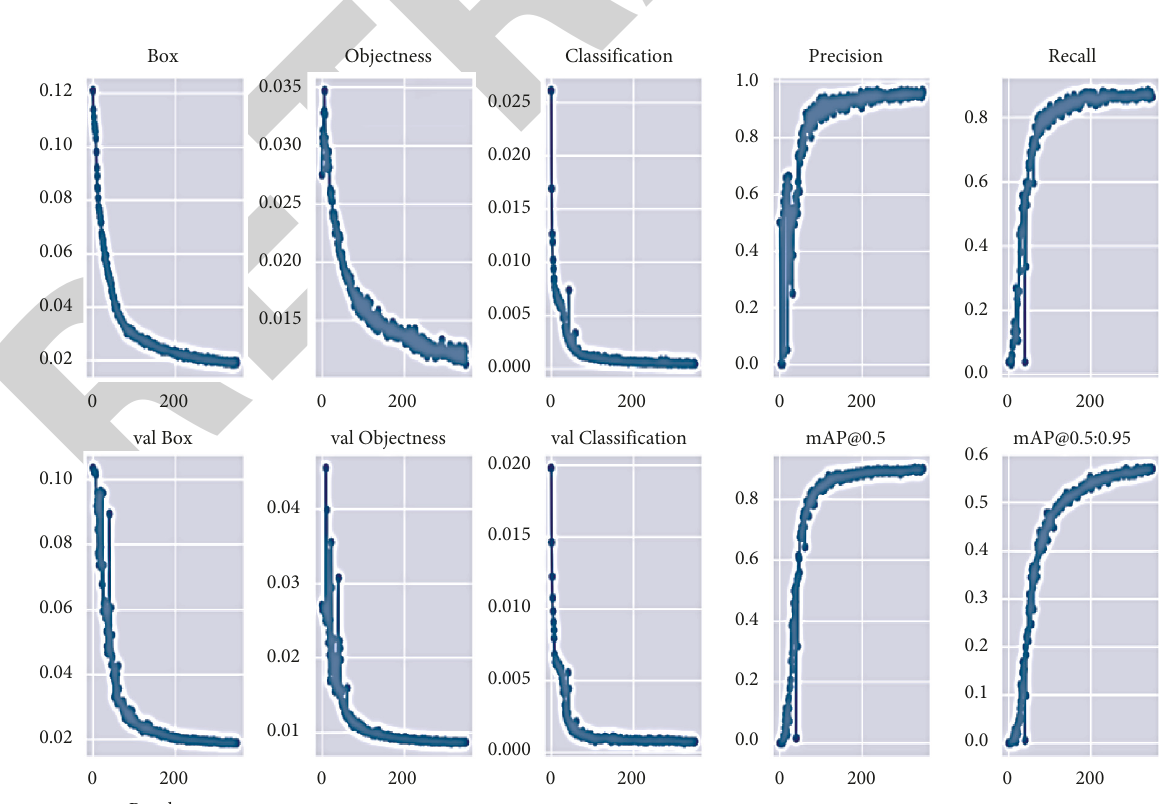
Figure 11: Atlas of graphs of geared kinematic